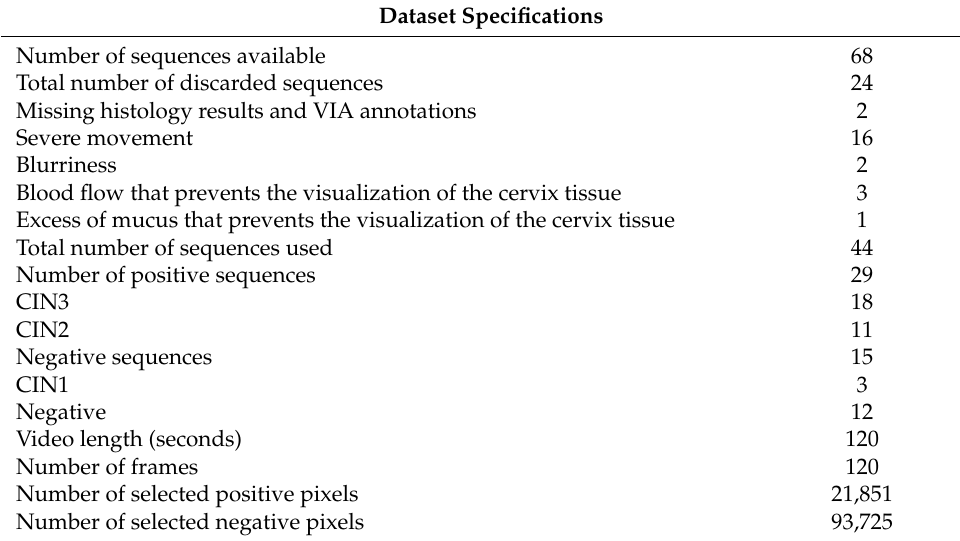
Table 1. Dataset specifications.